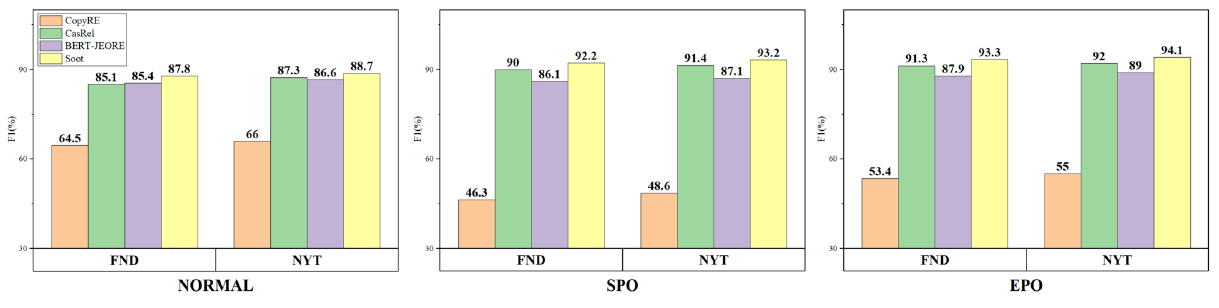
Figure 5. F1 values on different triplet